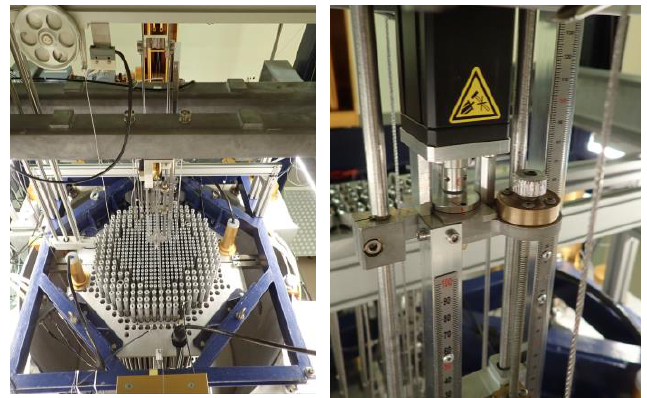
Figure 6 . PISTIL installed in the core center of CROCUS (left), its motor and position adjustment system (right)